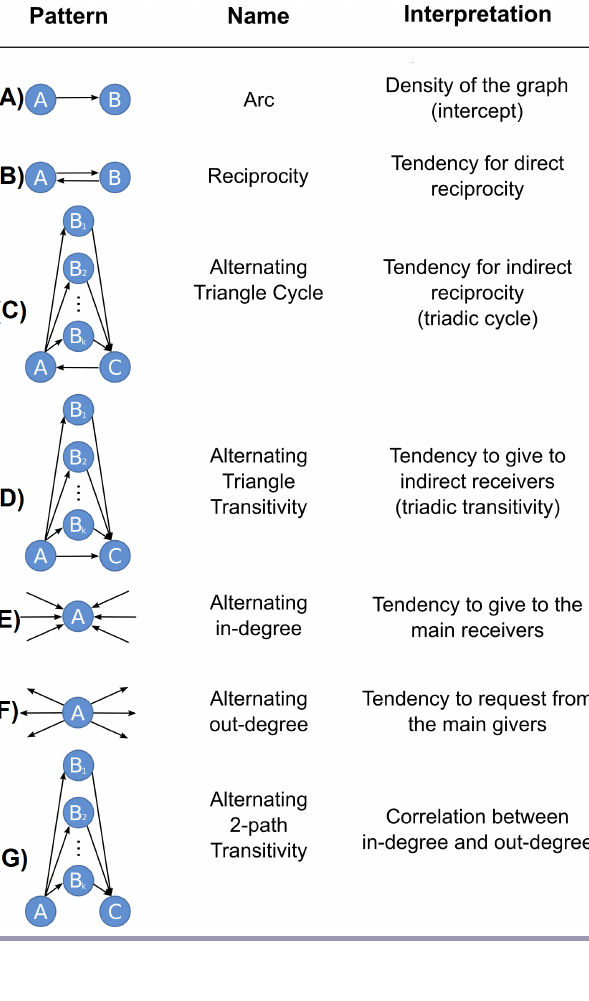
Fig. 1. Endogenous patterns tested in the analysis of plant circulation networks (adapted from Robins et al.